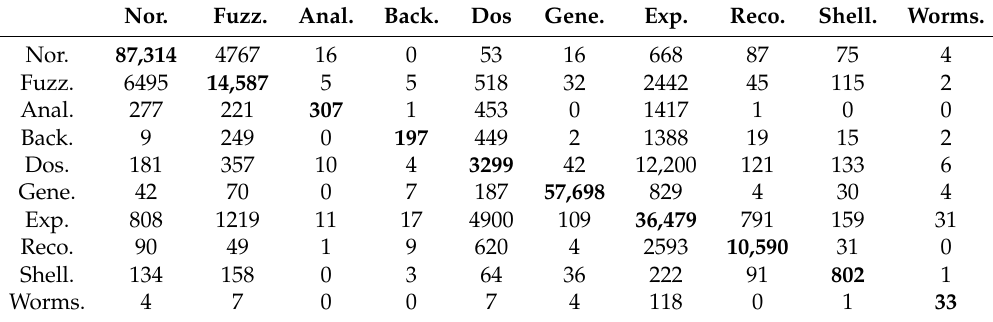
Table 11. Normal and various attacks Confusion Matrix for the UNSW-NB15 dataset classification. Nor. Fuzz. Anal. Back. Dos Gene. Exp. Reco. Shell. Worms. Nor. 87,314 4767 6495 518 2442 45 115 Anal. 277 221 307 1 453 0